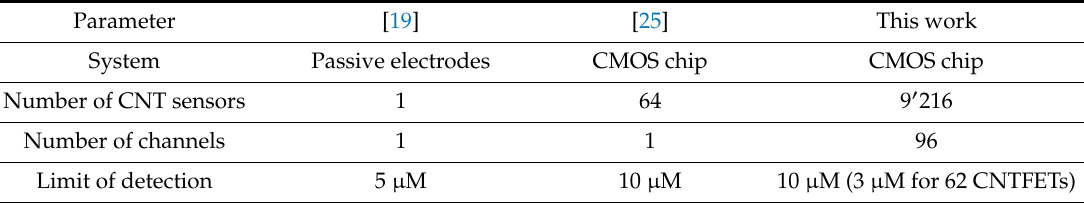
Table 1. Comparison of the performance of the designed system with the other references.